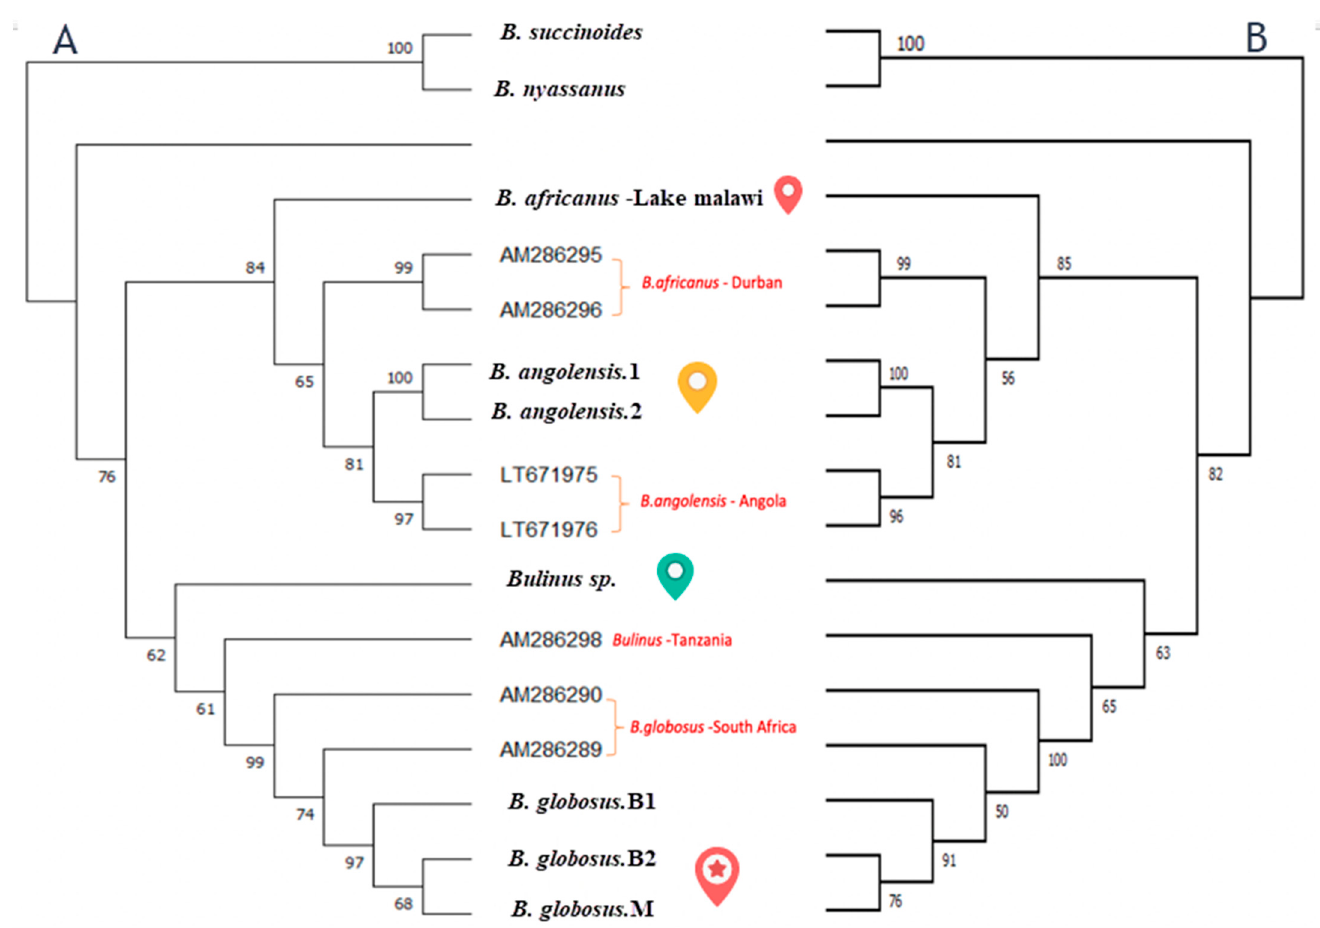
Figure 5. Two phylogenetics trees using maximum likelihood ( A ) and neighbour-joining method ( B ) for Bulinus from Lake Malawi. Both the tree of a 467 bp fragment of the ( cox 1) gene for B. forskali, B. succcinoides, B. nyassanus, B. africanus, B. globosus, B. angolensis and Bulinus sp. (unidentified) collected in this study. Plus, previously published sequences labelled with their accession number in Genbank and collection pint (red). The numbers at the nodes indicate bootstrap proportion based on 1000 replications. The symbols beside the nodes corresponded to specimens that are mentioned above in map distribution.